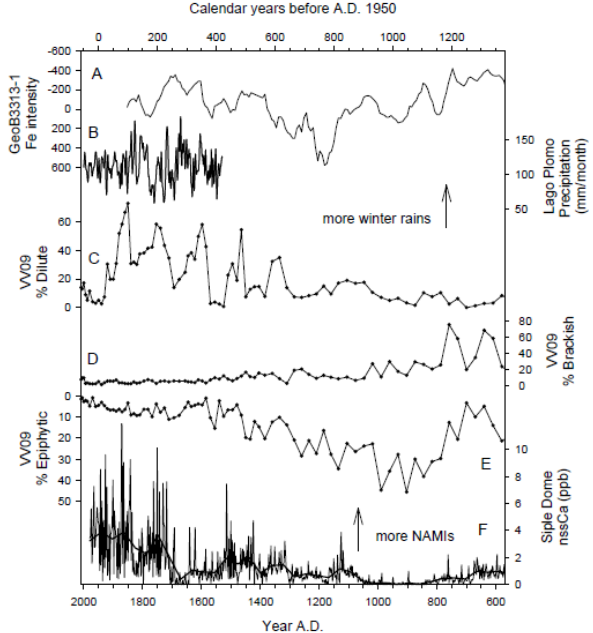
Fig. 8. Comparison of records from Southern Africa with records from Antarctica and Chile. (A) Iron intensity series from Chilean marine core GeoB 3313-1, five-point average in counts per second; lower intensity indicates more humid conditions along the coast (Lamy et al., 2001); data courtesy of F. Lamy. (B) Inferred win- ter precipitation from Lago Plomo (Elbert et al., 2011). (C–E) Di- atom assemblages from Verlorenvlei core VV09 grouped as eco- logical indicators; profile of epiphytic taxa is shown with y-axis inverted. (F) Higher non-seasalt calcium concentrations at Siple Dome represent greater dust transport from austral mid-latitudes to West Antarctica by northern air-mass incursions (NAMI; Dixon et al., 2011). Profiles (A–E) are arranged to indicate increased winter precipitation